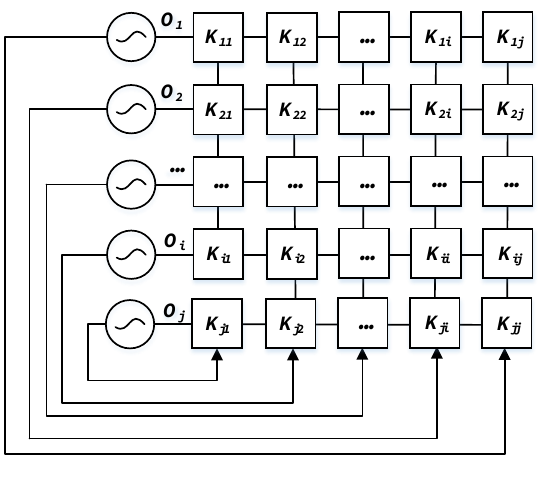
Figure 2. Topology of the proposed